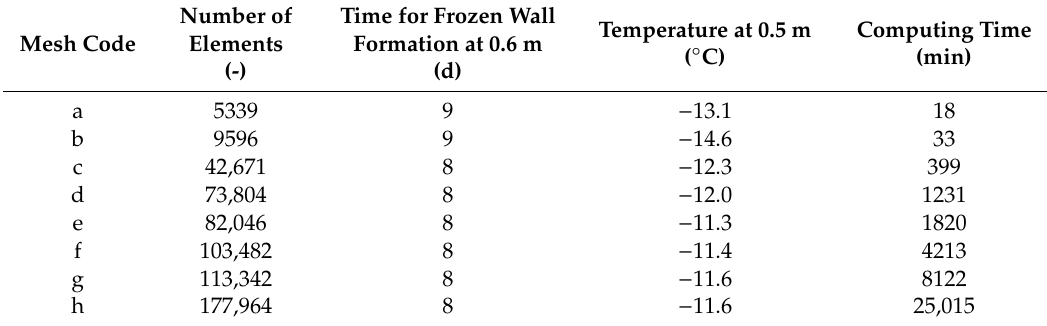
Table 2. Details of the meshes and obtained results for the grid-independent study.